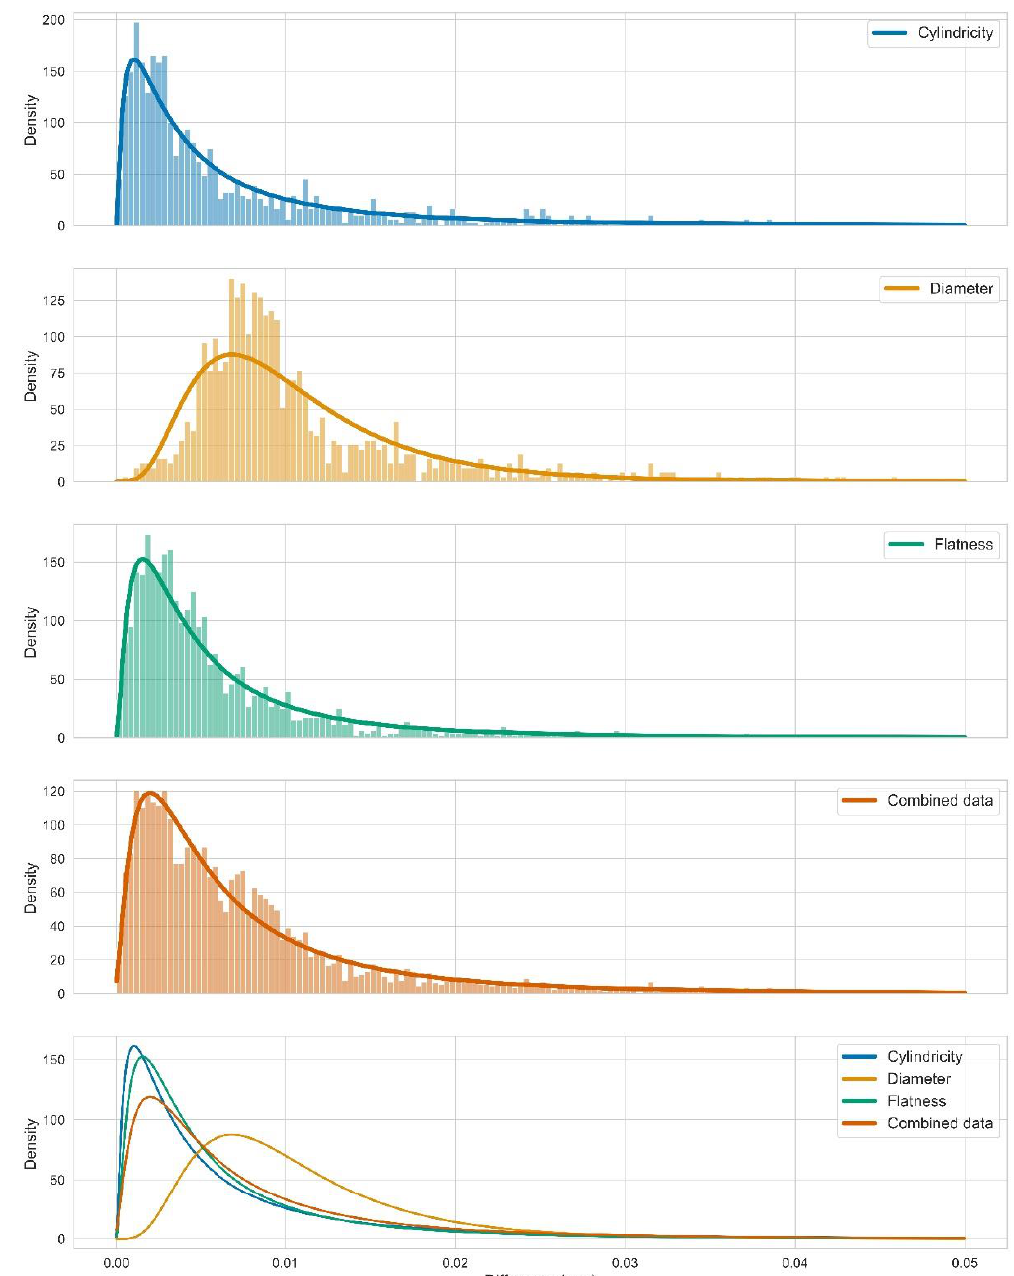
Figure 20. Lognormal probability distributions fitted to the measured data for selected features.